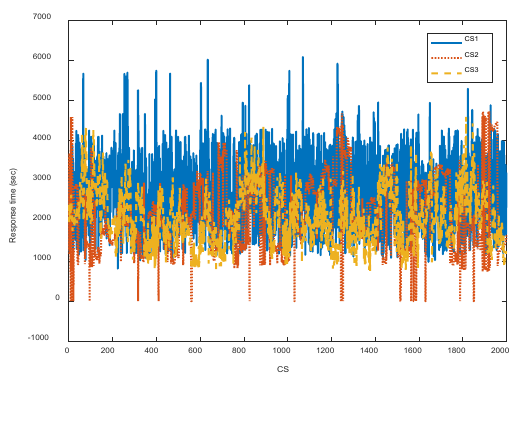
Fig. 2. Response time based on cloud services Fig .3. Throughput computation